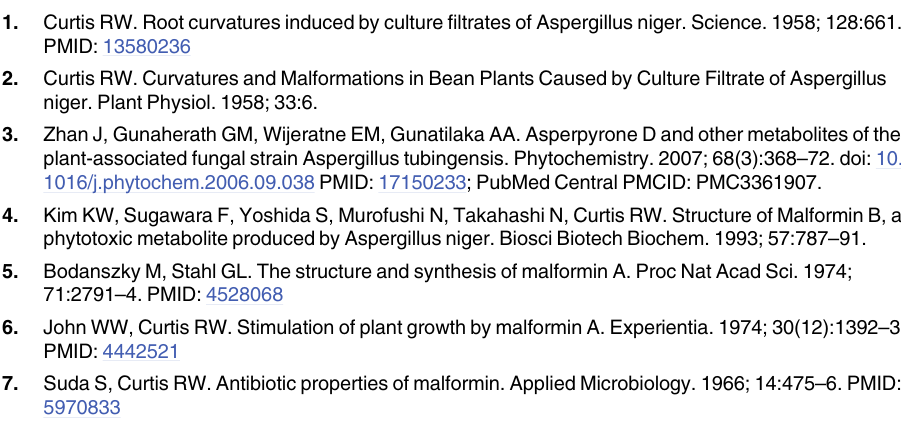
S4 Fig. Expression of total H2A.X in Colon 38 and HCT 116 cells treated with Malformin C. The expression of total H2A.X in Colon 38 and HCT 116 cells treated with different concen- trations of Malformin C (0 μ M, 0.14 μ M, 0.27 μ M, 0.54 μ M) and Hydroxyurea (1mM, 2mM) for 2-hour, 4-hour, 8-hour and 24-hour tested by Western blot, with β -Actin expression as an internal control. BenchMark TM Pre-stained Protein Ladder was used in this experiment. (TIF) S5 Fig. Expression of cleaved CASPASE 3 and LC3AII in Colon 38 and HCT 116 cells treated with Malformin C. The expression of cleaved CASPASE 3 and LC3AII in Colon 38 and HCT 116 cells treated with different concentrations of Malformin C (0 μ M, 0.14 μ M, 0.27 μ M, 0.54 μ M) for 4-hour, 8-hour and 24-hour was tested by Western blot, with β -Actin expression as an internal control. BenchMark TM Pre-stained Protein Ladder was used in this experiment. (TIF)